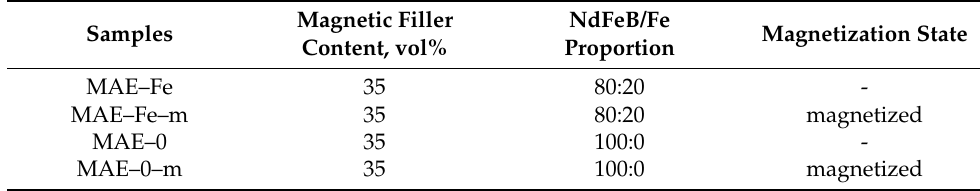
Table 1. The composition of MAE samples.